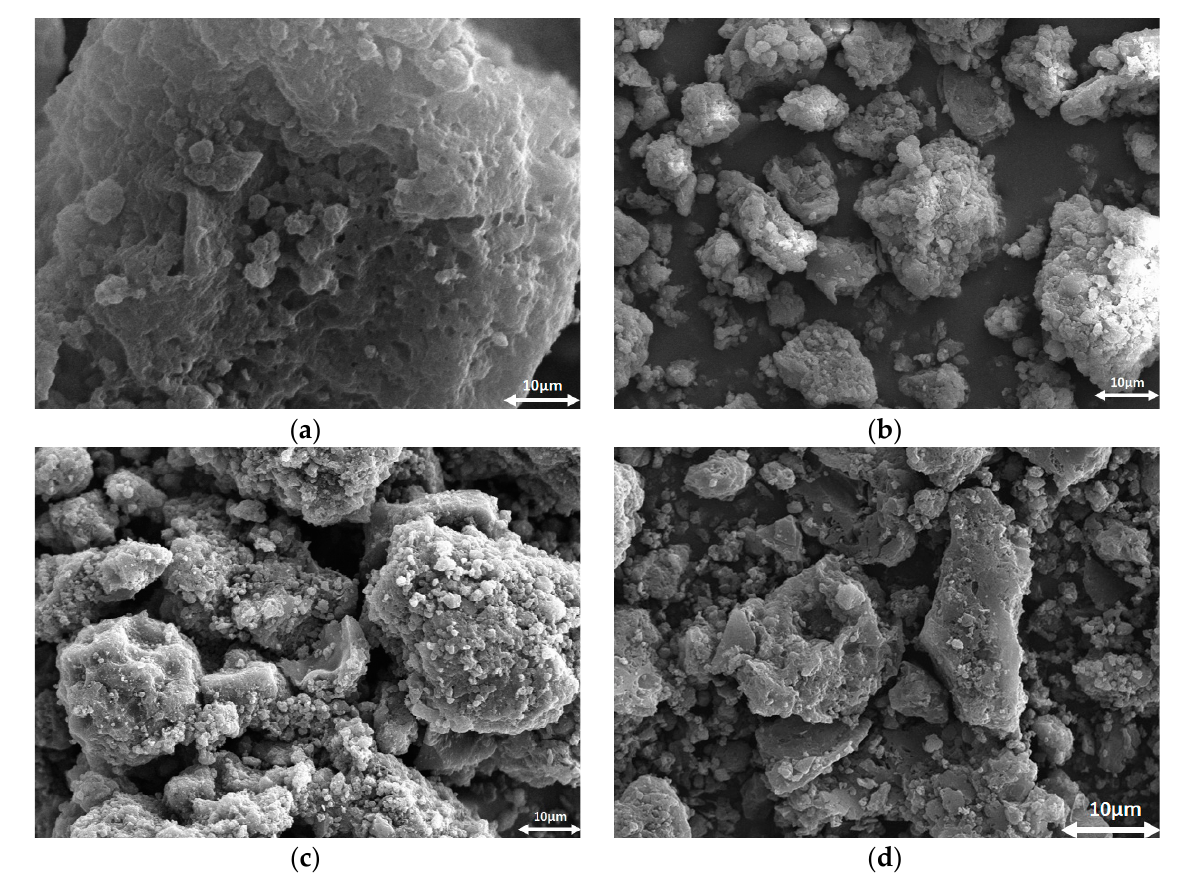
Figure 2. SEM micrographs of AFm ( a ), AFc ( b ), ACm ( c ) and ACc ( d ). The content of oxygen functional groups of acidic and basic character was measured by the Boehm titration method and the results are displayed in Table